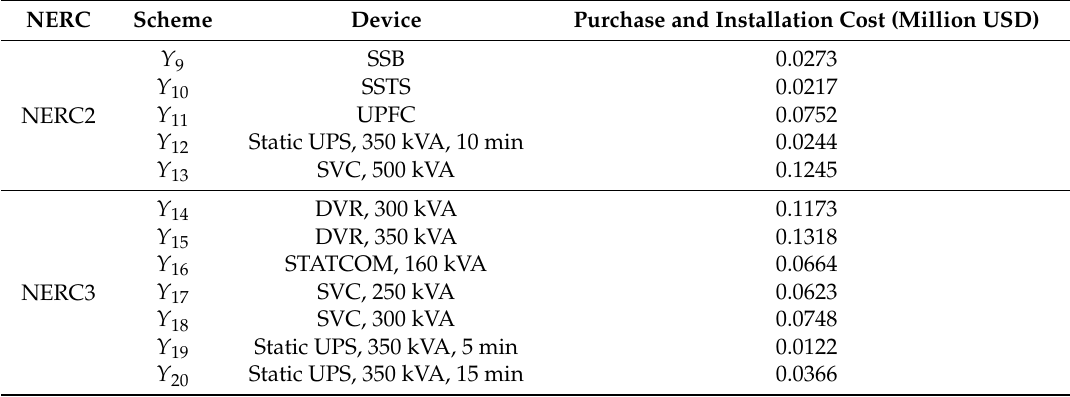
Table 5. Premium power investment schemes set provided by the NERC.